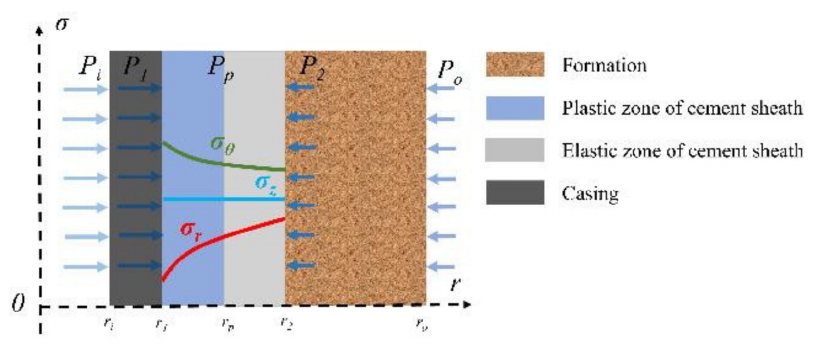
Figure 2. Schematic of casing–elastoplastic cement sheath-formation